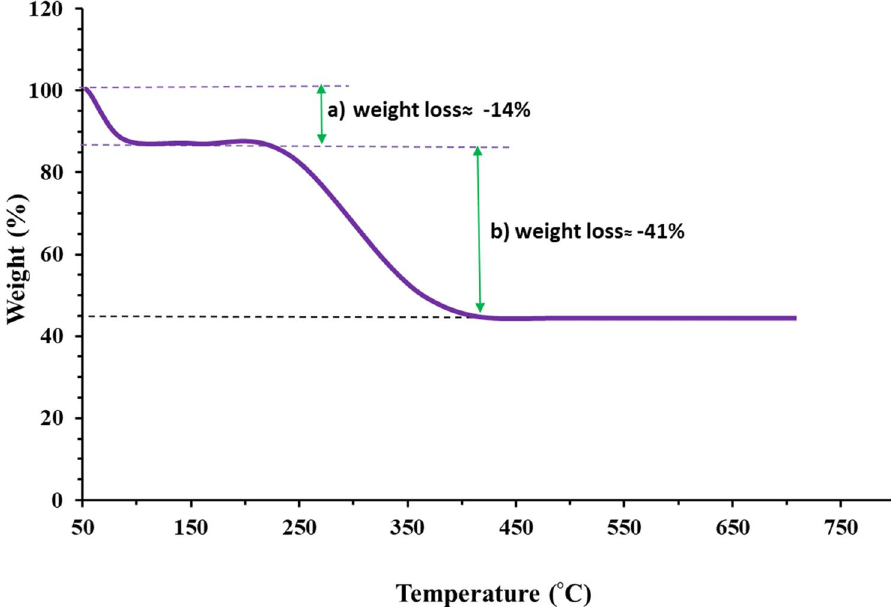
Figure. 5. TGA curve of green NiO NPs using marine red algae extract.